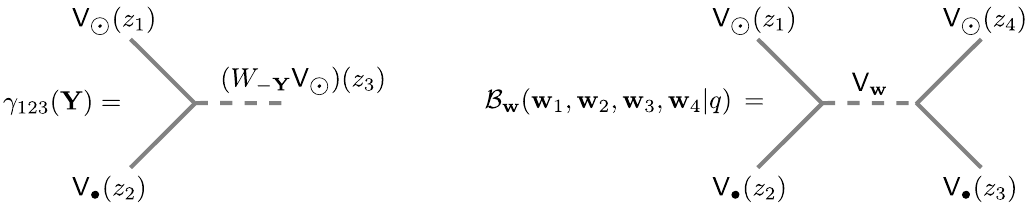
Figure 5 . This (cid:12)gure depicts the three and four point W-blocks. Using conformal symmetry, for three points, we set z 1 = 1 , z 2 = 1 and z 3 = 0, while for four points, we put z 1 = 1 , z 2 = 1, z 3 = q and z 4 = 0. The dashed lines indicate descendant